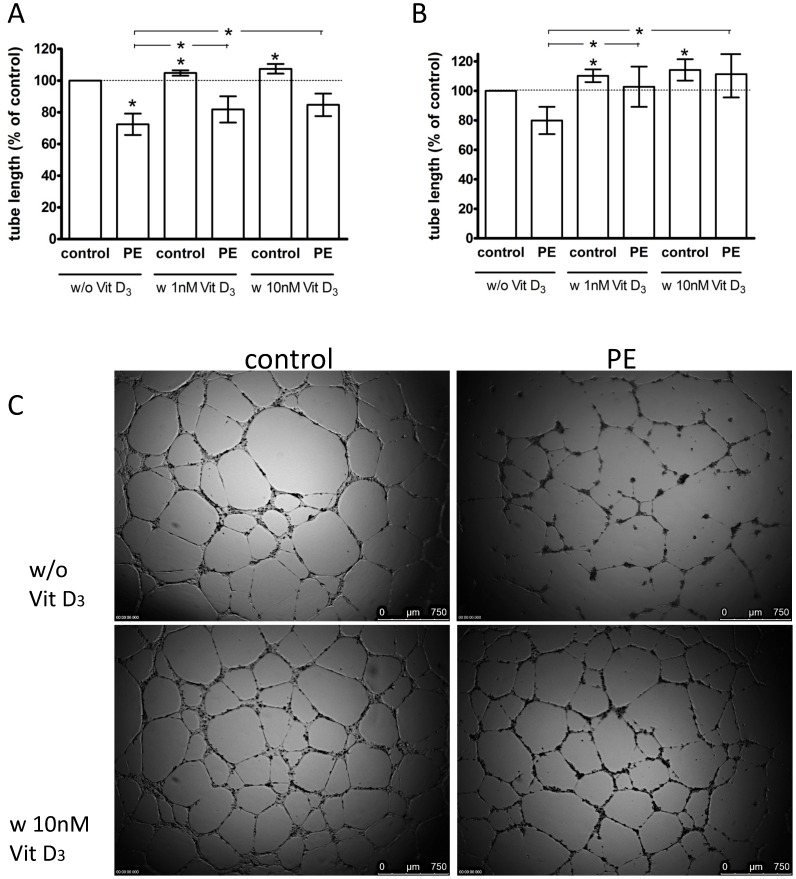
Effect of preeclampsia (PE) and 1,25(OH)2 vitamin D3 on capillary-tube formation in a Matrigel assay.ECFCs were cultured in endothelial basal medium (EBM) + 5% FBS (A) or without FBS (B) and treated with 1 nM or 10 nM 1,25(OH)2 vitamin D3 or without vitamin D3. Control: uncomplicated pregnancy. Capillary-tube formation (average total tubule length per microscopic field) was analyzed after 14 h by visual microscopy at 2.5× magnification. Data are expressed as percentage of control. Results represent mean values of total tubule length ±SEM of at least 8 independent experiments. *P<0.05 vs. untreated control or (as indicated by horizontal lines above the vertical bars) vs. untreated PE for 1,25(OH)2 vitamin D3 effects. C: Representative photomicrographs of ECFCs in Matrigel assay with EBM +5% FBS. Scale bar represents 750 µm.